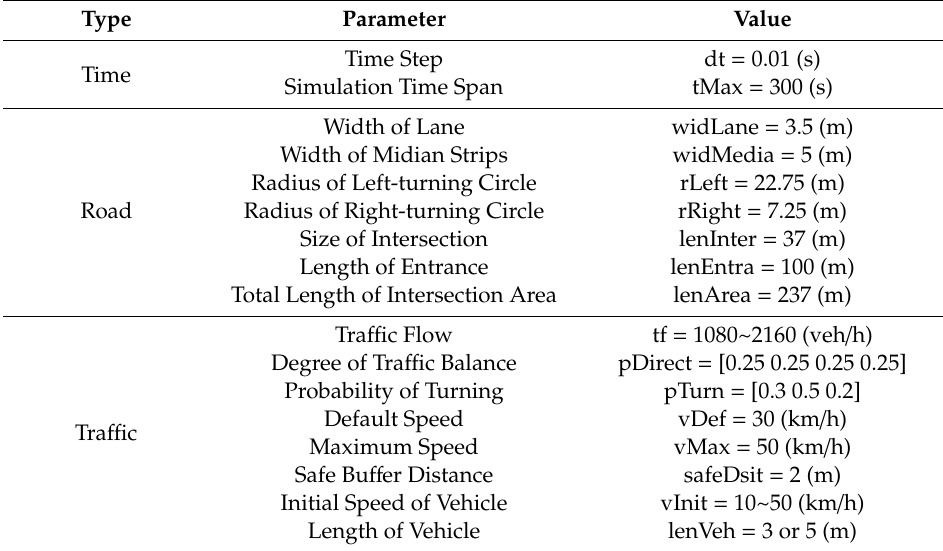
Table 3. Simulation parameters setup.